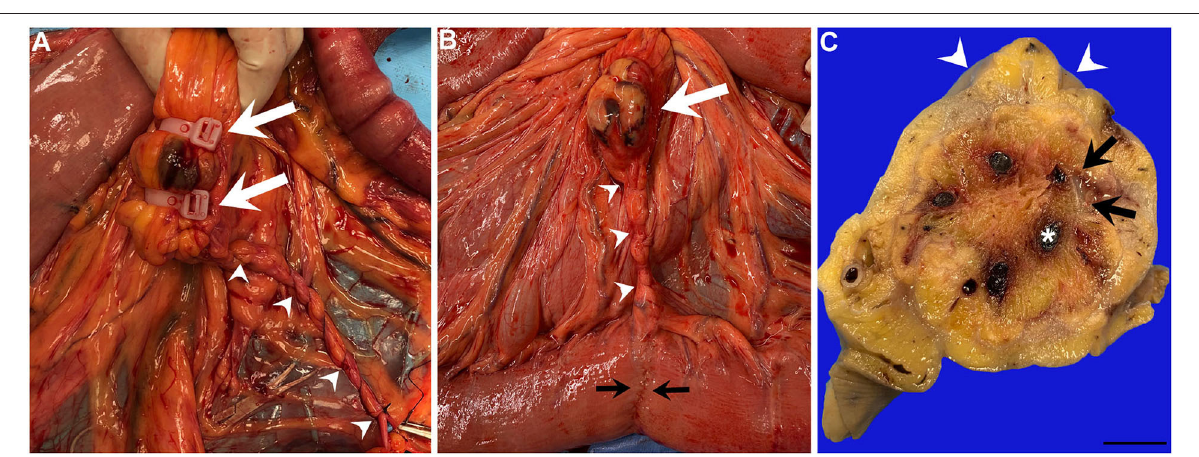
FIGURE 2 | (A) In situ photograph of the jejunal mesenteric NCT placement sites at the time of surgery (white arrows) adjacent to the mesenteric rent site repaired with simple continuous suture pattern (white arrowheads). (B) In situ photograph of the jejunal mesenteric NCT placement site at the time of the second surgery (white arrow) adjacent to the mesenteric rent repair site (white arrowheads) and jejunojejunostomy site (black arrowheads). (C) Ex situ formalin fixed serial section of the NCT site shows a portion of the curvilinear NCT cable ring (black arrows) encircling the jejunal vasculature within the center (asterisk); the serosa is encapsulated by smooth white fibrous connective tissue (white arrowheads) (scale bar =